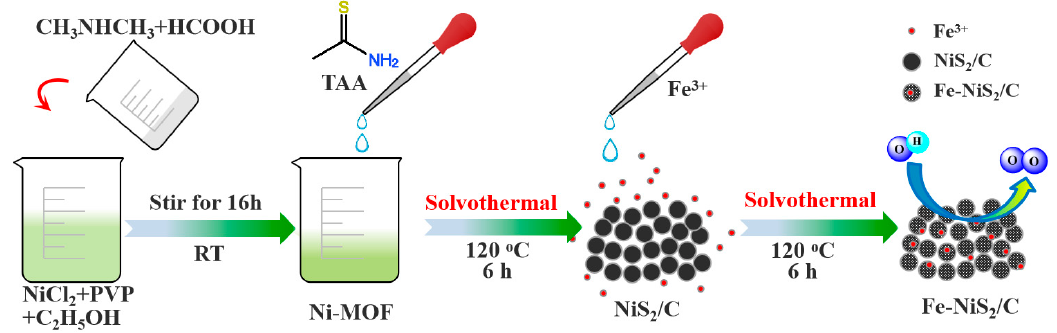
Scheme 1. Schematic illustration of the preparation of Fe-NiS 2 /C samples.